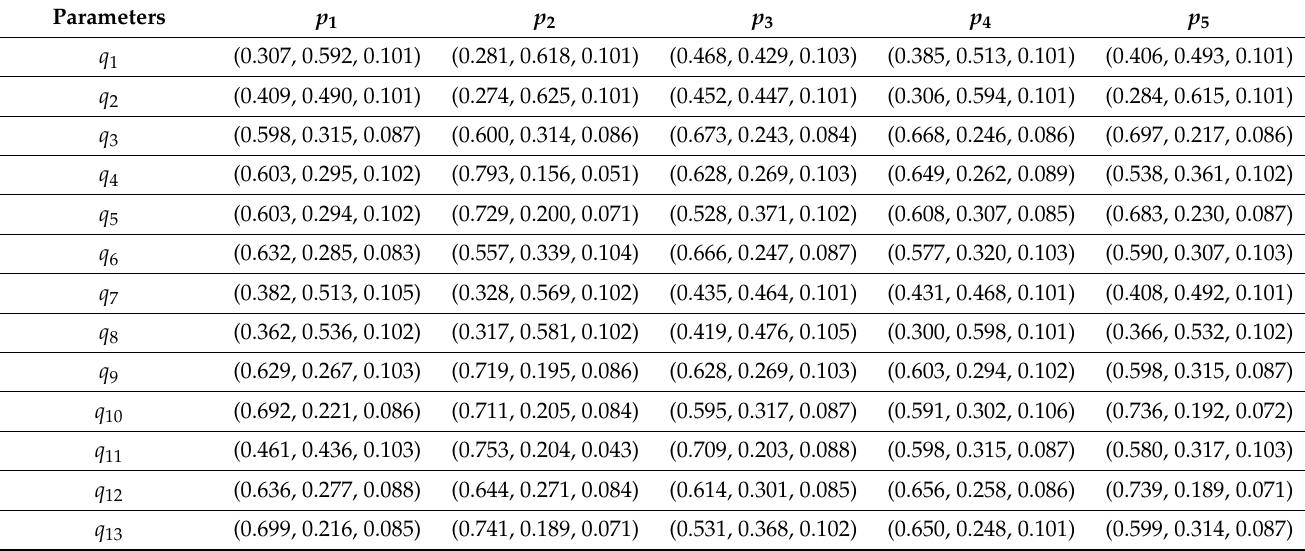
Table A2. The AIF-DM for prioritizing the BESSs.